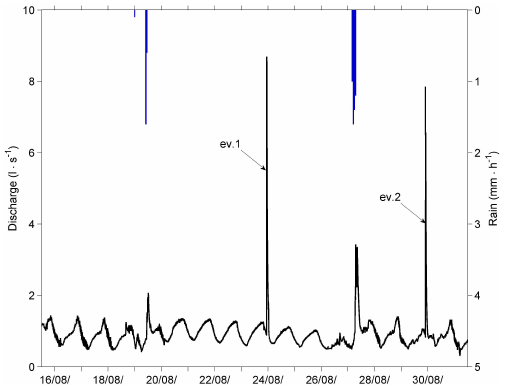
Fig. 5. Hyetograph and discharge at the catchment outlet (site MW) 10days before and during the flooding events in August